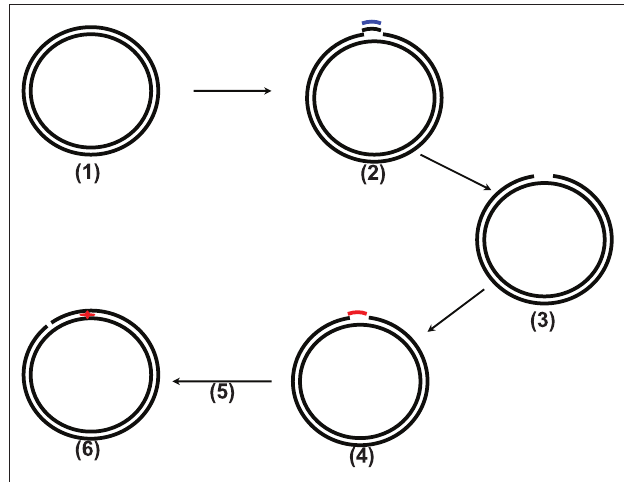
Figure 2 | illustration of the whole procedure of this new method. (1) the original pWDAH1A/SH1B plasmid; (2) Nt.BstNBI digestion to produce two nicks followed by addition of 20 × biotinylated supplementary oligo; (3) two rounds of treatment with streptavidin beads and column to remove the biotinylated oligo to generate gap DNA; (4) the mismatch-containing DNA oligo added to anneal with the gap DNA, followed by a ligation reaction; (5) CsCl density ultracentrifuge, DNA recovery, and nick generation using Nt.BbvCI or Nb.BbvCI; (6) mismatch-containing DNA substrate (G/T mismatch or G/IU).